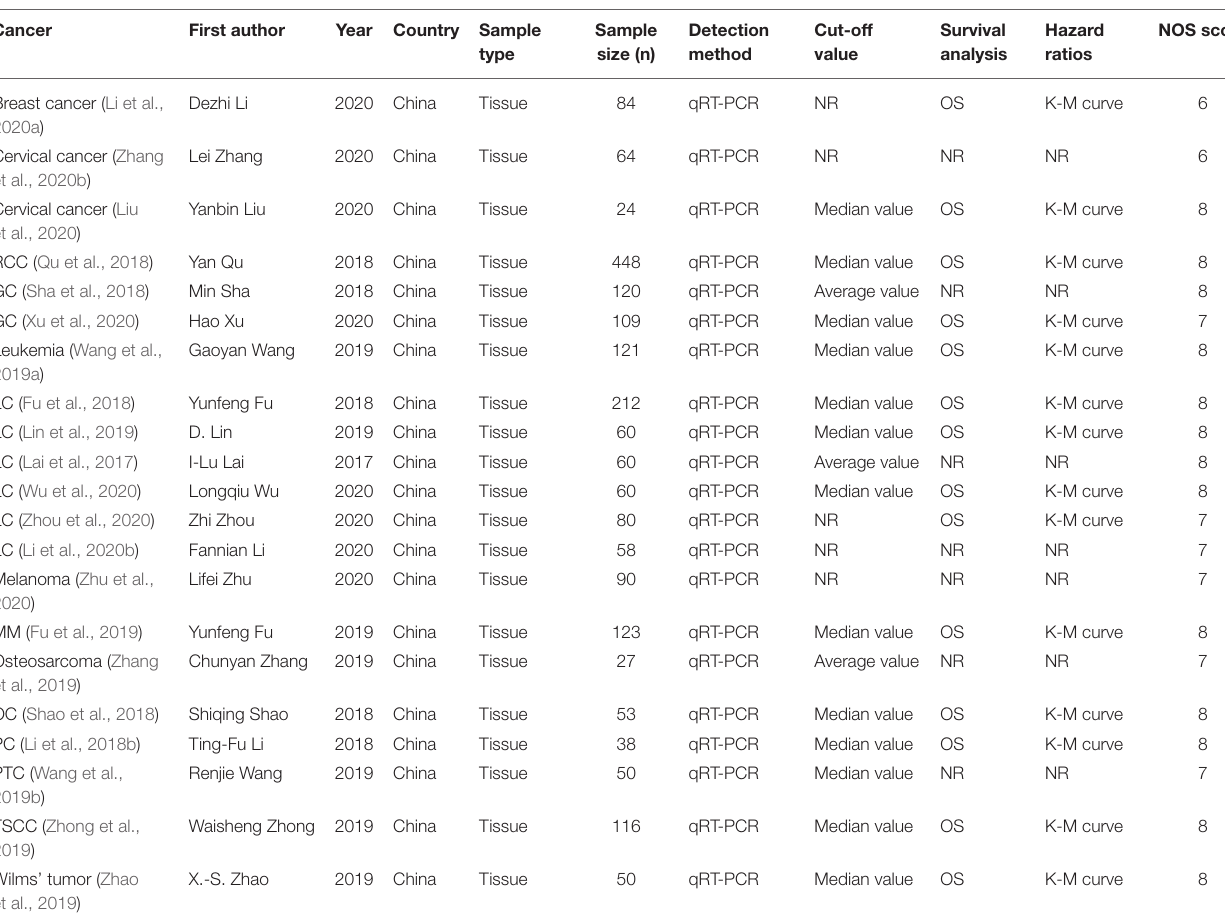
TABLE 1 | Characteristics of the included